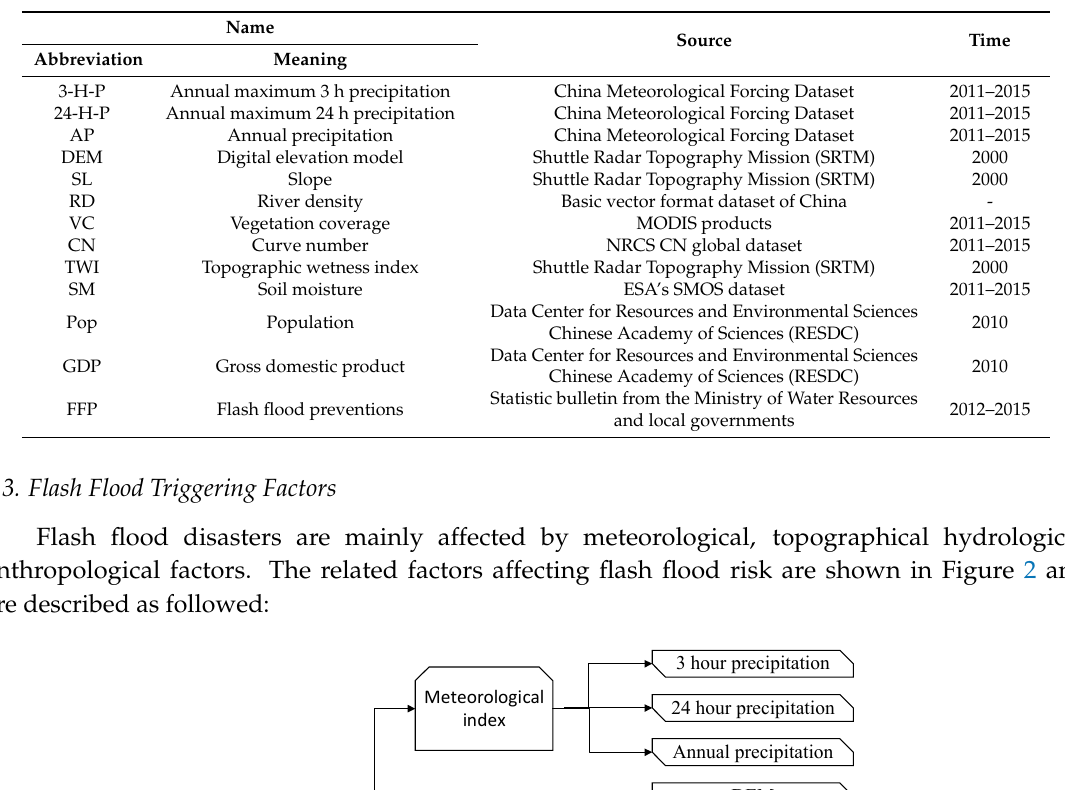
Table 1. Factors, flood inventories and data sources.